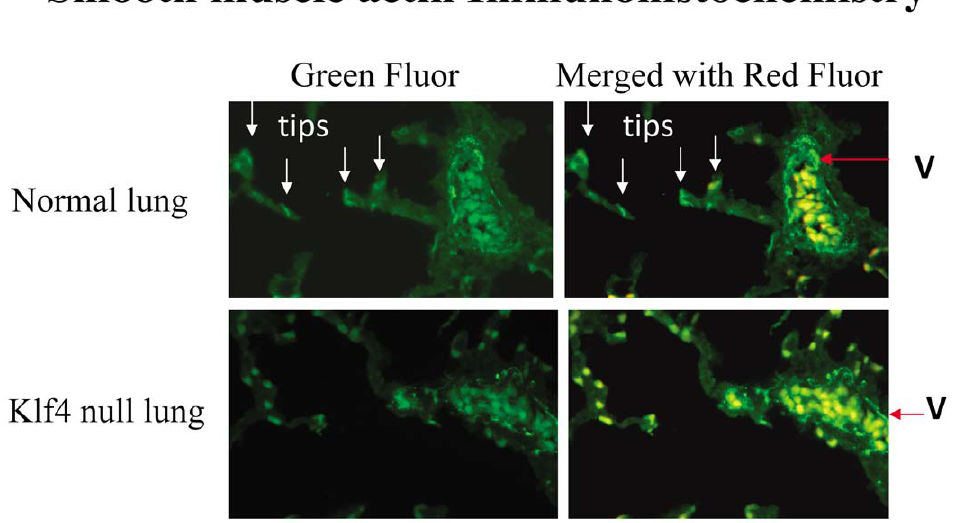
Figure 13. Immunohistochemistry for smooth muscle actin in lung at birth. In the normal lung at 6 hours after birth, a specific smooth muscle actin (SMA) signal (green) is present in myofibroblasts at the saccular tips (tips) and vascular smooth muscle cells from a large blood vessel (V) in the left panel (green fluorescence) and the right panel (green despite merger with red autofluorescence). Nonspecific yellow signal (green merged with red autofluoresecence) is present in hematopoietic cells in large blood vessels. In the Klf4 null lung, however, the specific green SMA signal is only present in vascular smooth muscle cells from a large blood vessel (V). Cells in saccular tips in the left panel are yellow after merger with red autofluorescent signal in the right panel denoting non-specific signal likely originating from hematopoietic cells in small blood vessels within the lung interstitium as in large blood vessels.